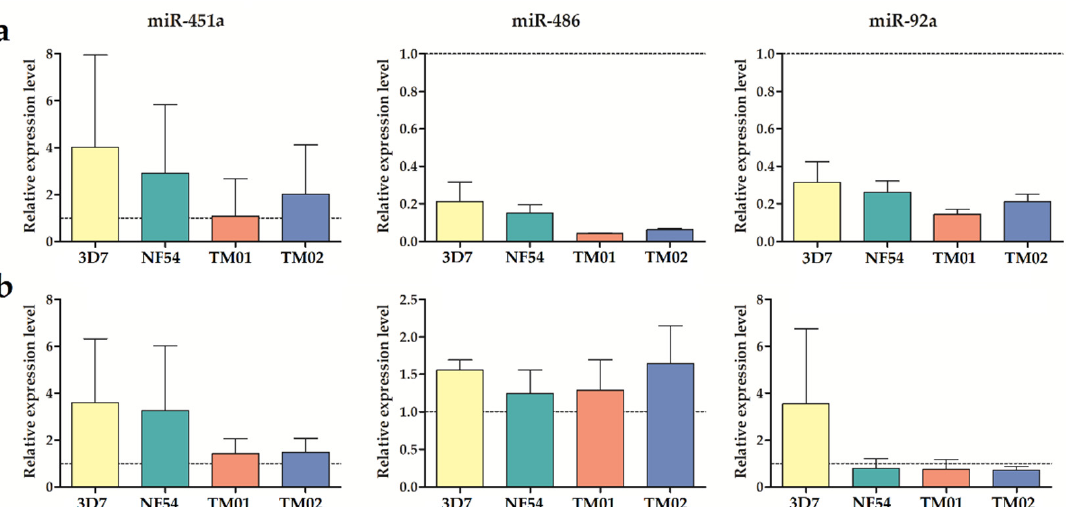
Figure 6. The relative miRNA expression levels of miR-451a, miR-486, and miR-92a in Pf -EVs. ( a ) Pf -MV and ( b ) Pf -Exo derived from 3D7, NF54, TM01, and TM02. The results were shown as mean ± SEM from three independent experiments. The lines indicate the levels of the control A23187-EVs.